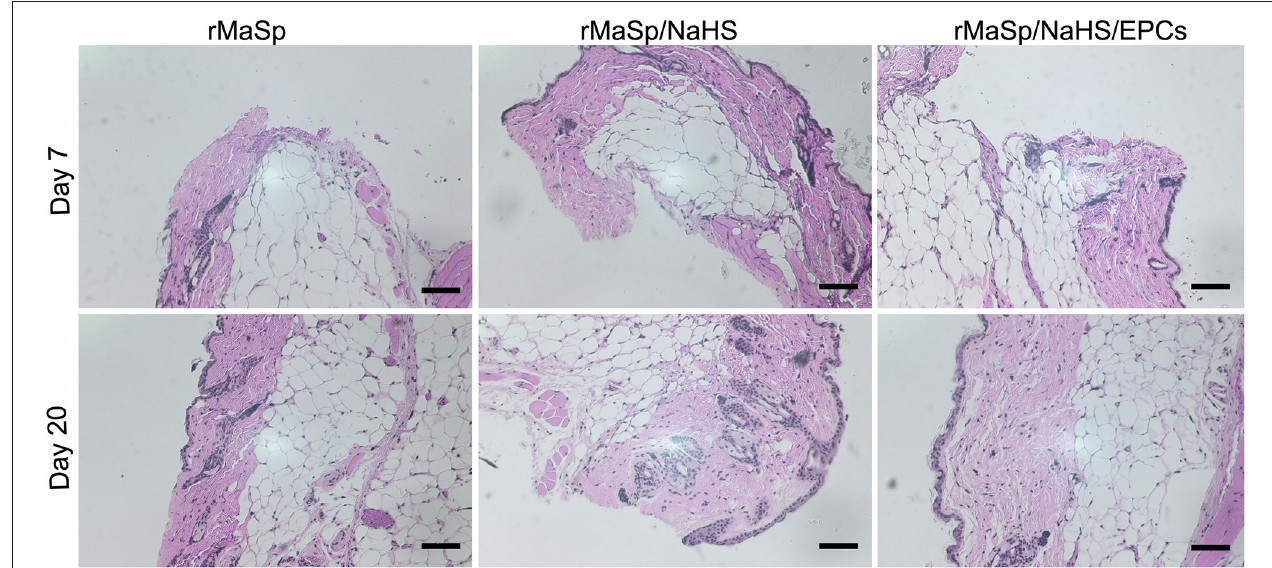
FIGURE 8 | Hematoxylin and eosin (HandE) staining of wound site on days 7 and 20. Quantified granulation formation calculated from HandE staining on RMASP vs. RMASP-JK1 on days 7 and 20. Quantified reepithelization calculated from cytokeratin staining on RMASP vs. RMASP-JK1 on days 7 and 20. The statistical differences were performed using ANOVA. ** p < 0.01, * p < 0.05 compared with the RMASP group, n > 3. The scale bar is 500 µ m.